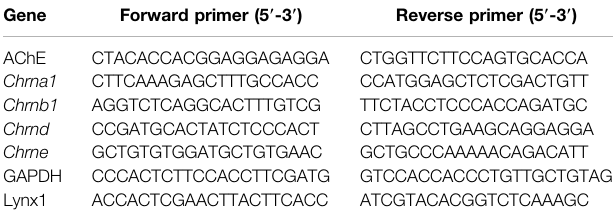
TABLE 1 | qPCR primer sequences.